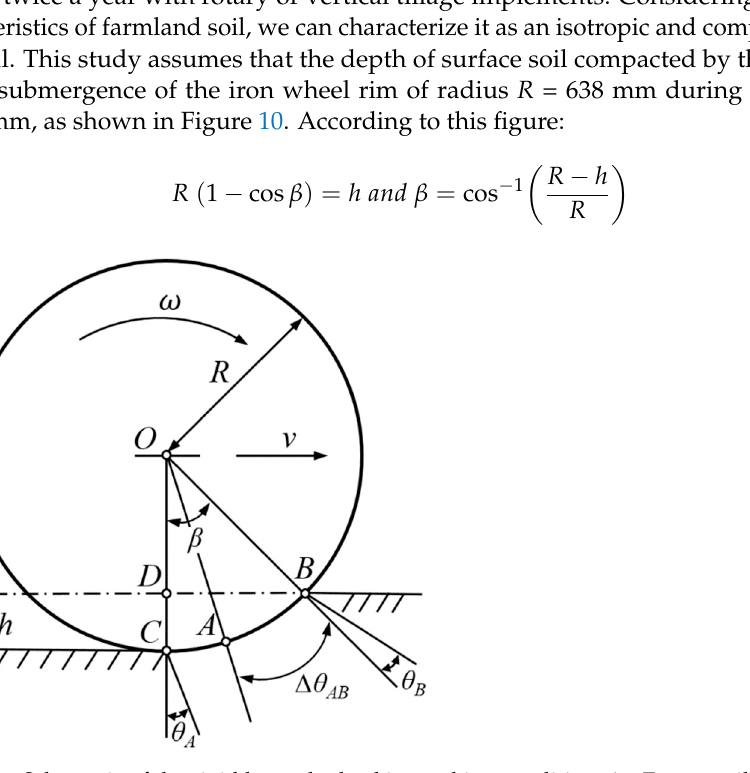
Figure 10. Schematic of the rigid lugged wheel in working condition: 1—Front untilled soil surface line; 2—Back compressed soil surface line; h: compressed depth of cultivated soil = 15 mm.